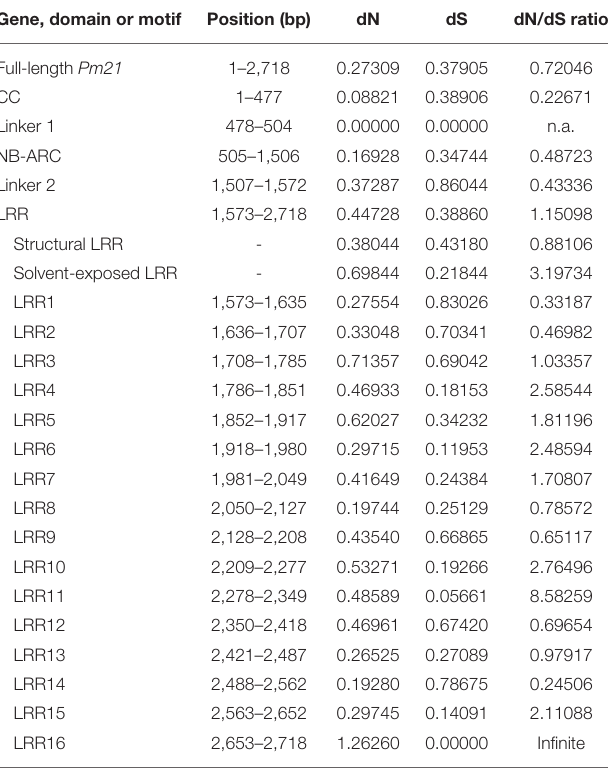
TABLE 2 | dN, dS, and dN/dS ratio of Pm21 alleles and their domains or motifs. Gene, domain or motif Position (bp) dN